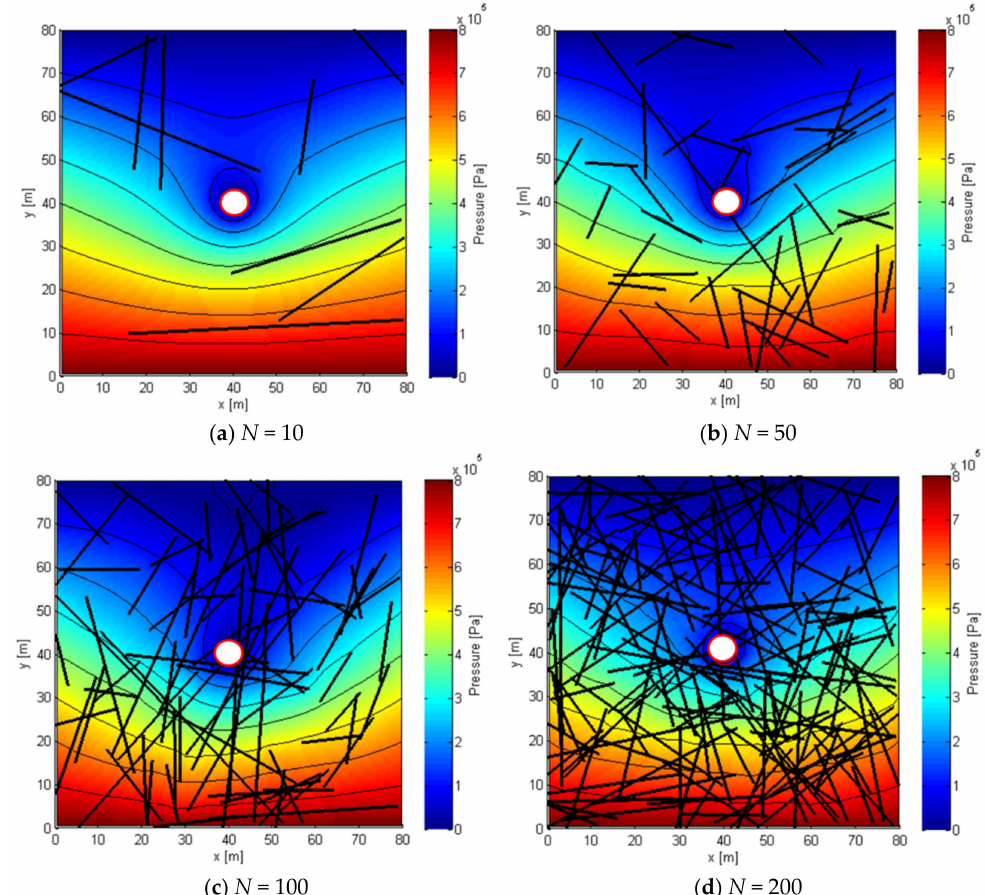
Figure 10. Water pressure distribution of fractured rock tunnel under different fracture